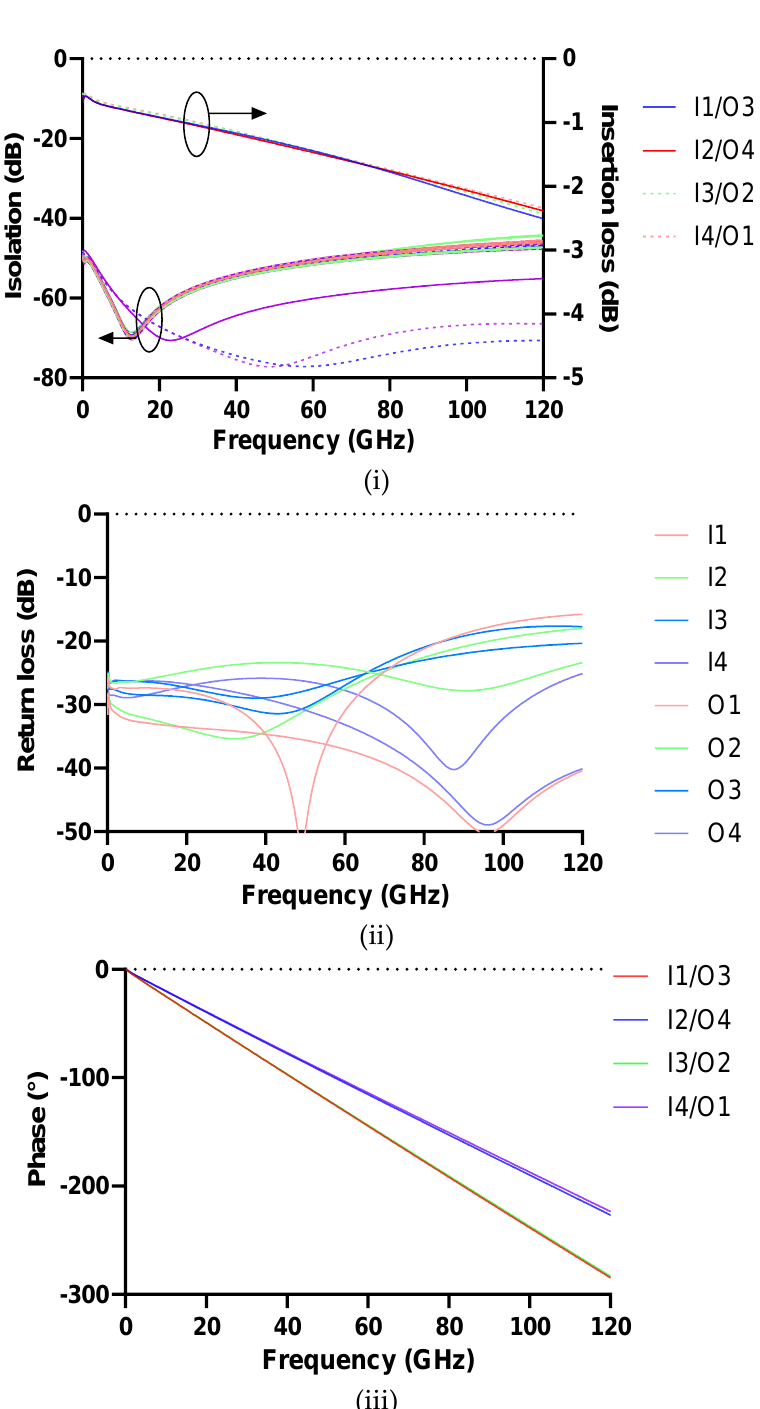
Figure 9. RF performance of set 3 with (i) showing the insertion losses of the connected paths and isolations between the disconnected ports, (ii) the return losses at all ports and (iii) the connected paths’ phases. It should be noted that no legends are included for the port-to-port isolations due to a large number of disconnected ports.